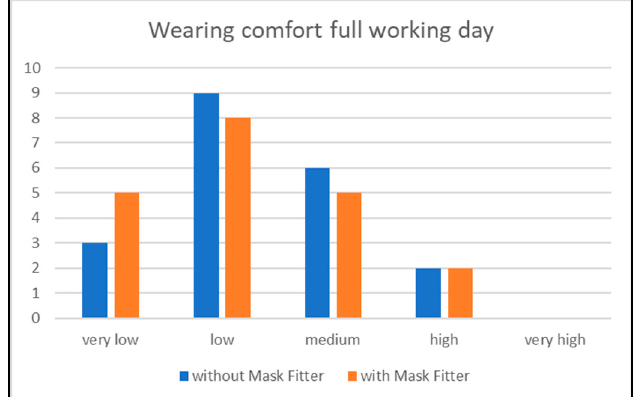
Figure 8. Wearing comfort over full working day, without and with Mask Fitter.